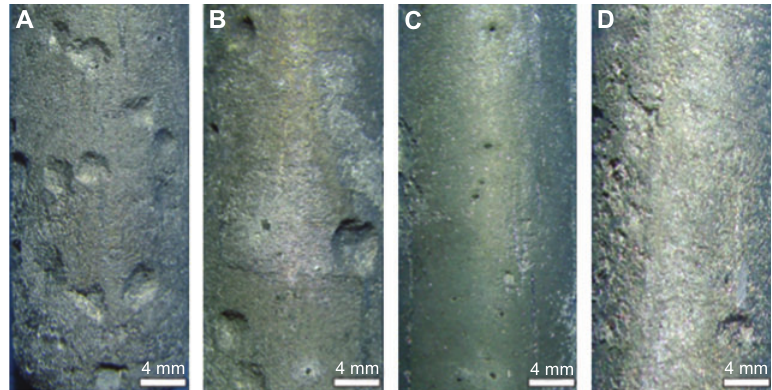
Figure 9 Surface pores as observed by stereoscopy in Al-wt. % Si alloy with an applied TMF under solidifi cation stages. (A) Apply TMF until molten metal is cooled down to 873 K. (B) Apply TMF during the fi rst third of the time taken for crystal growth. (C) Apply TMF during the second third of the time taken for crystal growth. (D) Apply TMF during the last third of the time taken for crystal